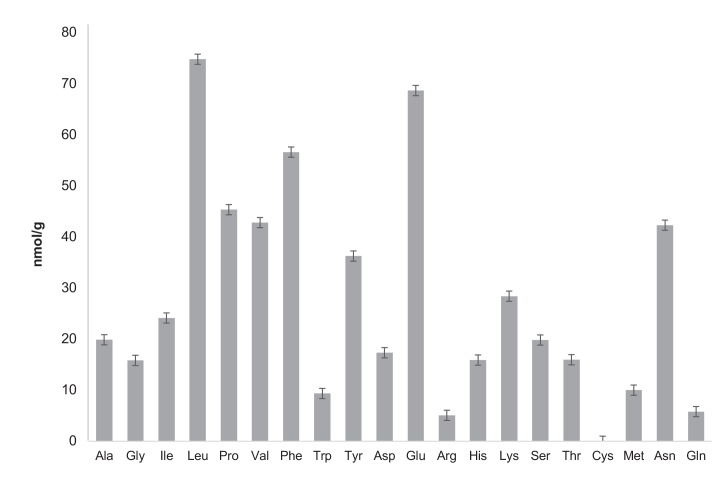
Quantification of free amino acids in CCA.Free amino acid characterization and quantification have been carried out by the Proteomics and Mass Spectrometry Facility of the Donald Danforth Plant Science Center and each analysis has been performed in triplicate. Samples were prepared as recommended by the Proteomics and Mass Spectrometry Facility of the Donald Danforth Plant Science Center instructions. For free amino acid analysis, 150 mg CCA was frozen in liquid nitrogen and ground in the presence of 600 μL of water:chloroform:methanol (3:5:12 v/v). Tubes were then centrifuged at full speed for two minutes and supernatant was recovered in a new 2 mL eppendorf tube. A second extraction with 600 uL of water:chloroform:methanol was performed followed by a two minute centrifugation at maximum speed. Supernatant was then recovered and combined with the previous supernatant in a 2 mL eppendorf tube. Then 300 uL of chloroform and 450 uL of water were added before centrifugation at full speed for two minutes. The upper phase was recovered and transferred to a new tube. Samples were dried in a speedvac overnight and stored at −20°C. The total concentration of free amino acids in CCA is 75.3 nmol/mL. Analysis of total amino acids was also performed by the Proteomics and Mass Spectrometry Facility of the Donald Danforth Plant Science Center. It highlights that free aminos are a very small fraction of total amino acid whose concentration is 16.5 ± 2.97 μmol/mL (six times less than the LB concentration measured by Sezonov et al. (2007)). Ala: alanine, Gly: glycine, Ile: isoleucine, Leu: leucine, Pro: proline, Val: valine, Phe: phenylalanine, Trp: tryptophan, Tyr: tyrosine, Asp: aspartate, Glu: glutamate, Arg: arginine, His: histidine, Lys: lysine, Ser: serine, Thr: threonine, Cys: cysteine, Met: methionine, Asn: asparagine, Gln: glutamine.